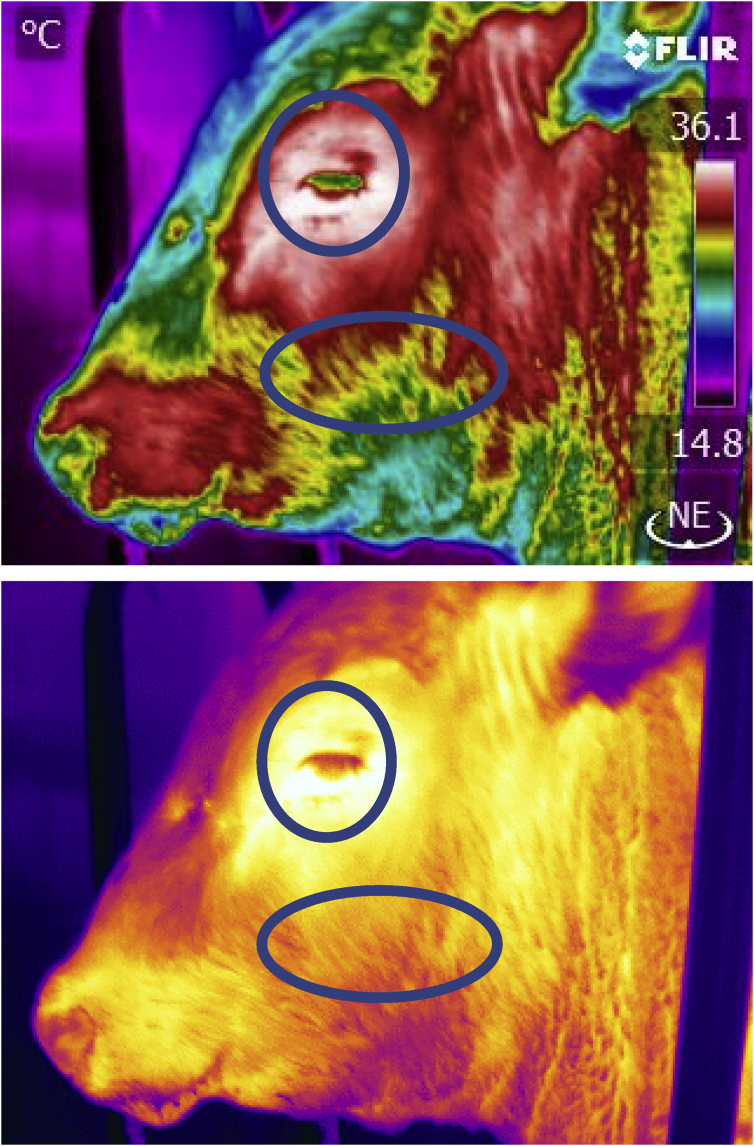
Infrared Thermograph of steer with a high orbital (eye) temperature of 37.5 C and high cheek mean temperature of 31.5 C. Areas used for orbital and cheek thermal values are depicted in rainbow palate (top) or lava palate (bottom).